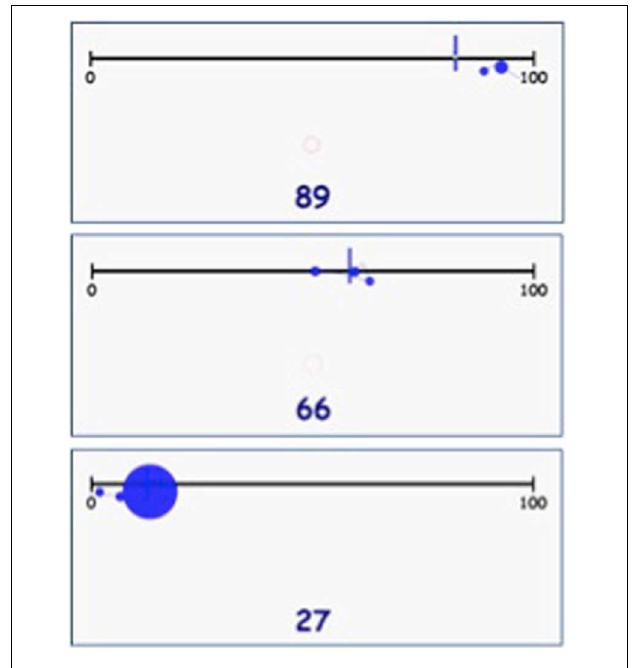
FIGURE 2 | Examples of the number estimation strategies counting-down/endpoint (top), midpoint (middle), and counting-up/beginpoint (bottom).